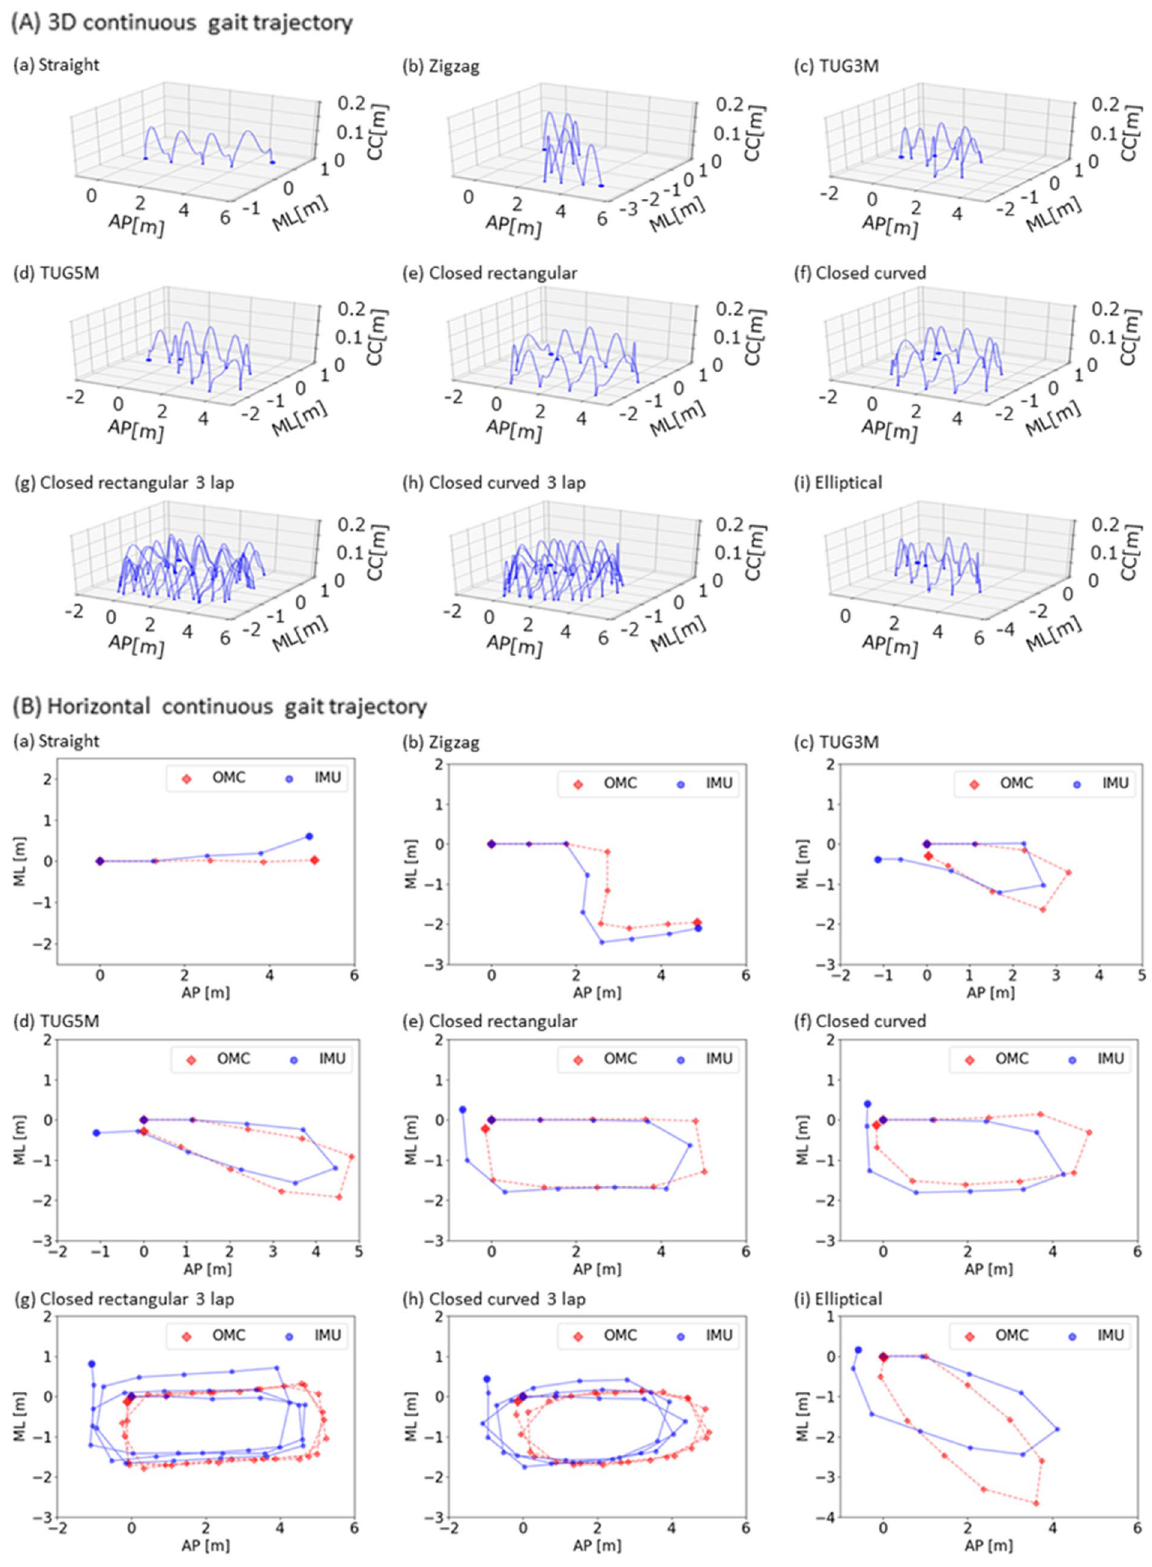
Figure 6. Examples of continuous gait trajectory estimated by the representative previous method with single shank-worn IMU in the nine walking route conditions. ( A ) 3D continuous gait trajectory, ( B ) Horizontal continuous gait trajectory, ( a ) straight, ( b ) zigzag, ( c ) TUG3M, ( d ) TUG5M, ( e ) closed rectangular, ( f ) closed curved, ( g ) closed rectangular 3 lap, ( h ) closed curved 3 lap, and ( i ) elliptical. In the axes, CC means craniocaudal direction, AP means anterior–posterior direction, and ML means medio-lateral